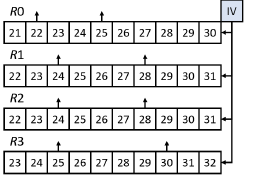
Figure 3: S 4 i +2